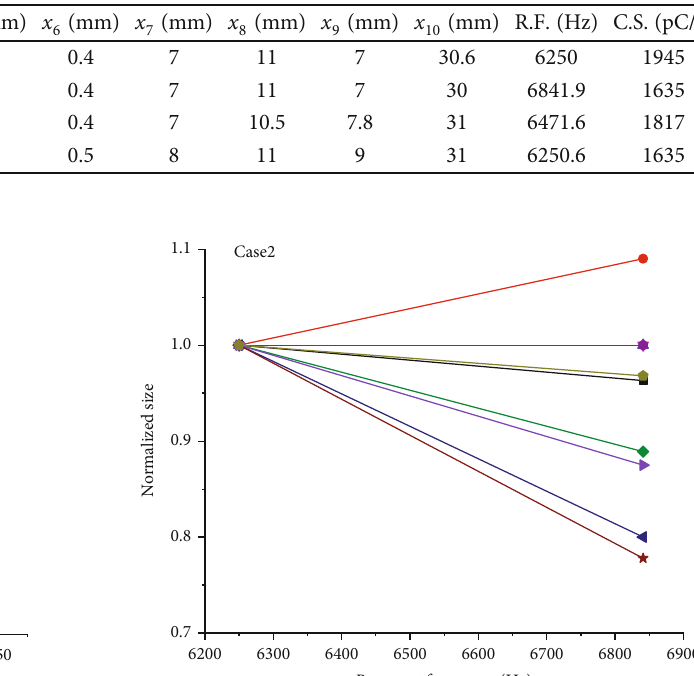
Table 4: Values of optimized design variables and the results of cases 1, 2, and 3.